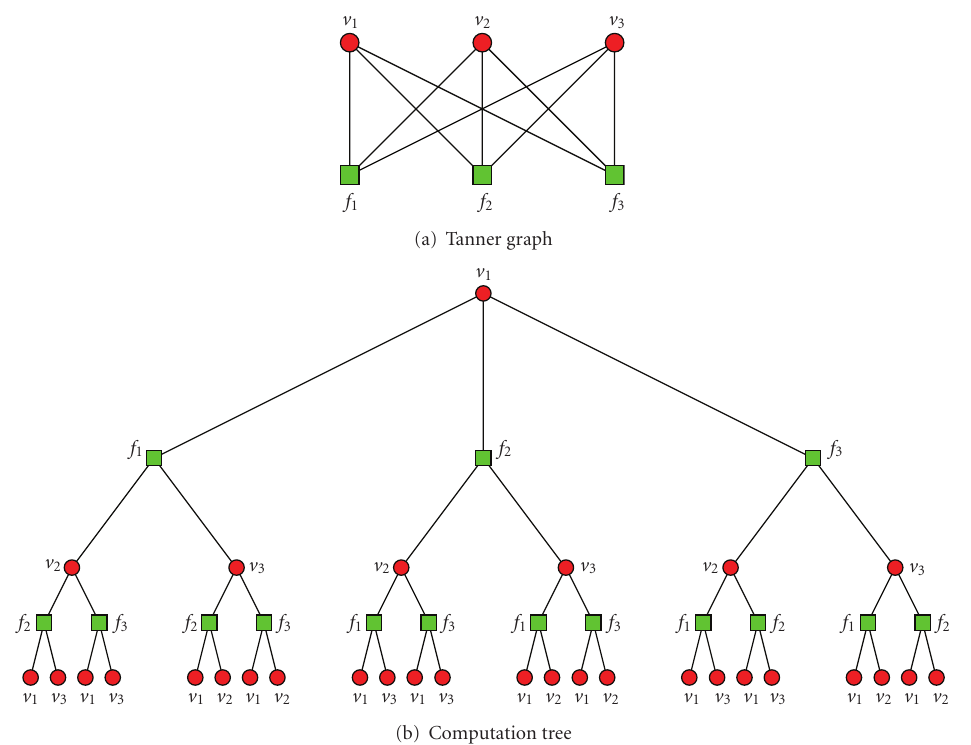
Figure 5: Computation tree of a simple repetition code after (cid:4) = 2 iterations.